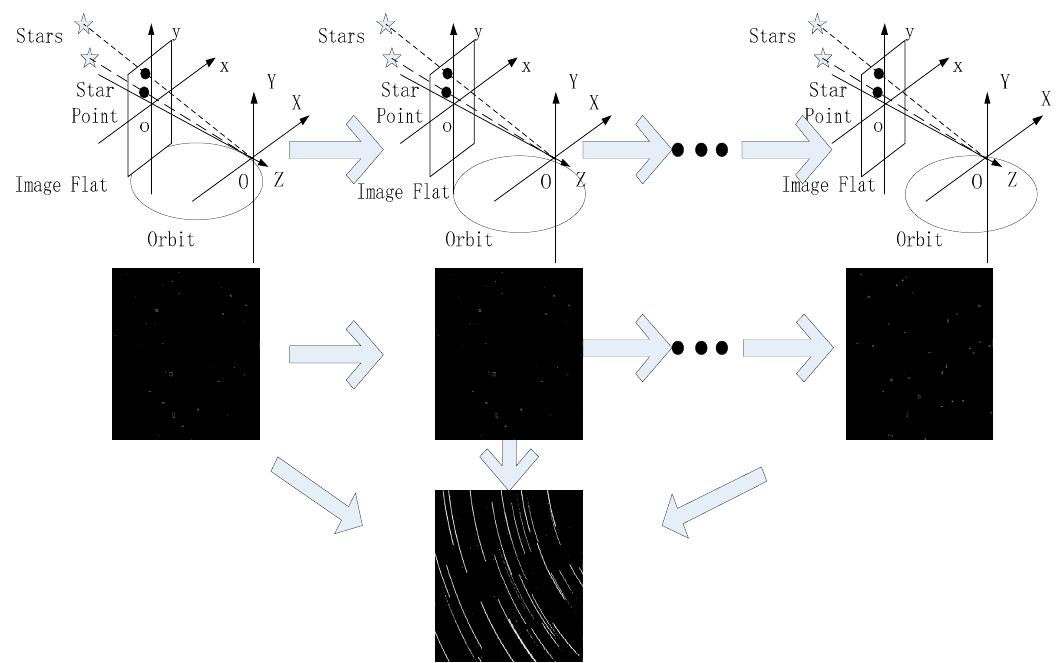
Figure 2. Schematic diagram of the ellipsoid model.